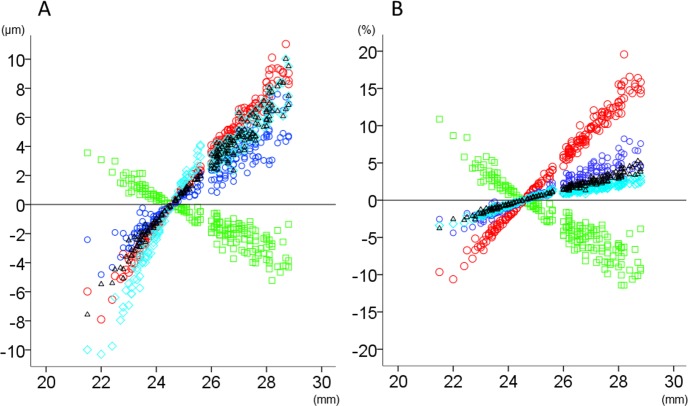
The relationship between axial length and thickness changes of retinal layers in the outer ring of analytical area after magnification correction.The thickness changes (μm; A) and relative thickness changes compared to the magnification-uncorrected thickness (%; B) after magnification correction were plotted against axial length. Green squares: retinal nerve fiber layer, Red circles: ganglion cell layer plus inner plexiform layer, Blue circles: ganglion cell complex, Light blue diamonds: total retina, Black triangles: outer retina.